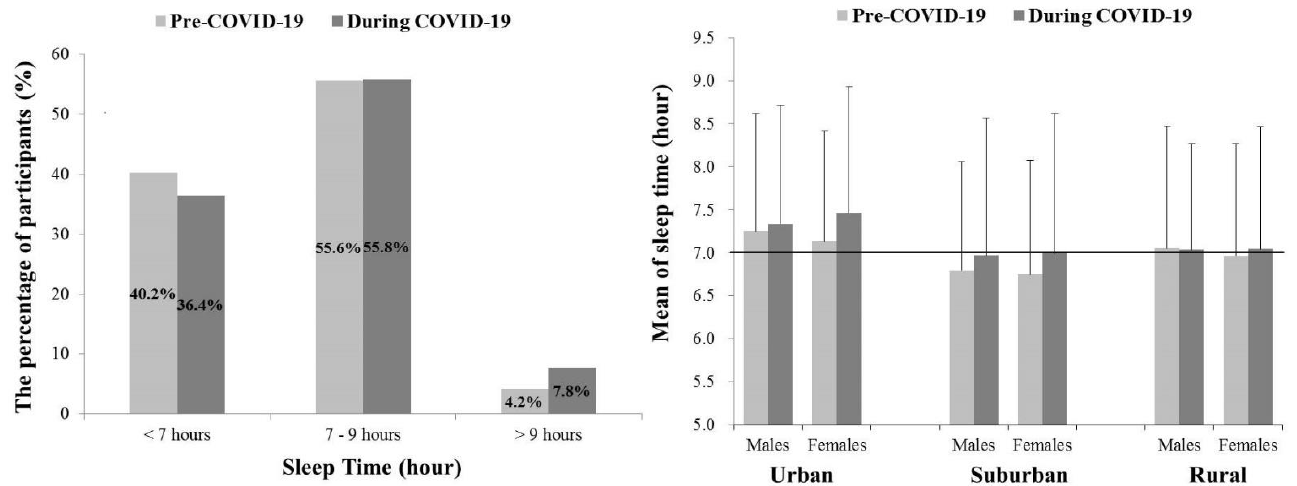
Figure 2. Mean of sleep time before and during COVID-19. Urban: includes a capital and metropolis city in South Korea, Suburban: includes a nearby city that surrounds the capital city, Rural: includes the rest of the cities except urban and suburban.